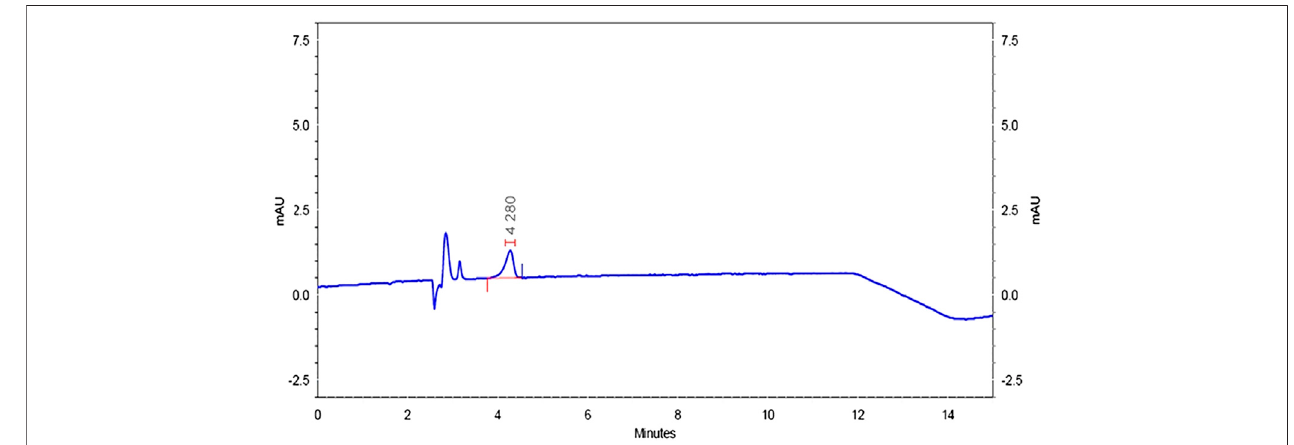
FIGURE 9 | Representative chromatogram of the fl umioxazin test item in acidic water.